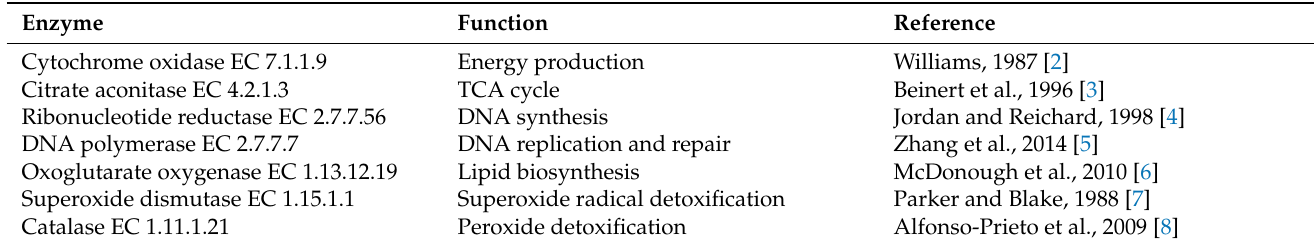
Table 1. Iron-dependent enzymes.